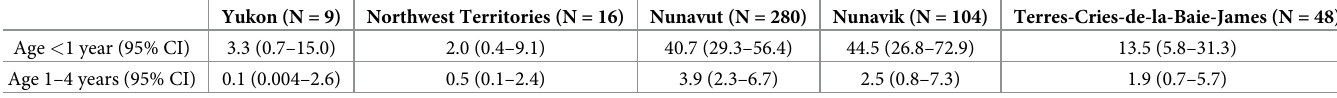
Table 2. Annual tertiary care acute respiratory infection related admission rates (per 1,000 population) of children transported urgently by air from five northern Canada regions between 2009 to 2014 1